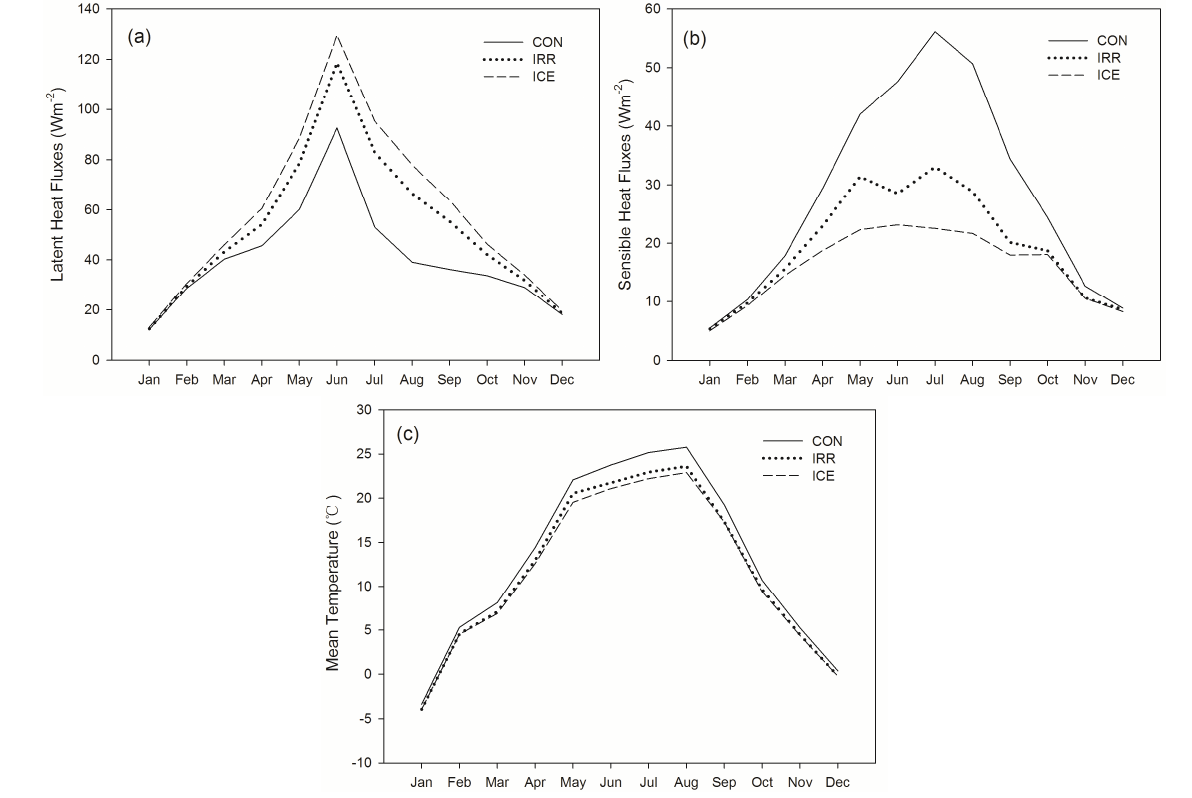
Figure 5. Annual cycles of ( a ) latent heat fluxes; ( b ) sensible heat fluxes; and ( c ) mean temperature for three land cover